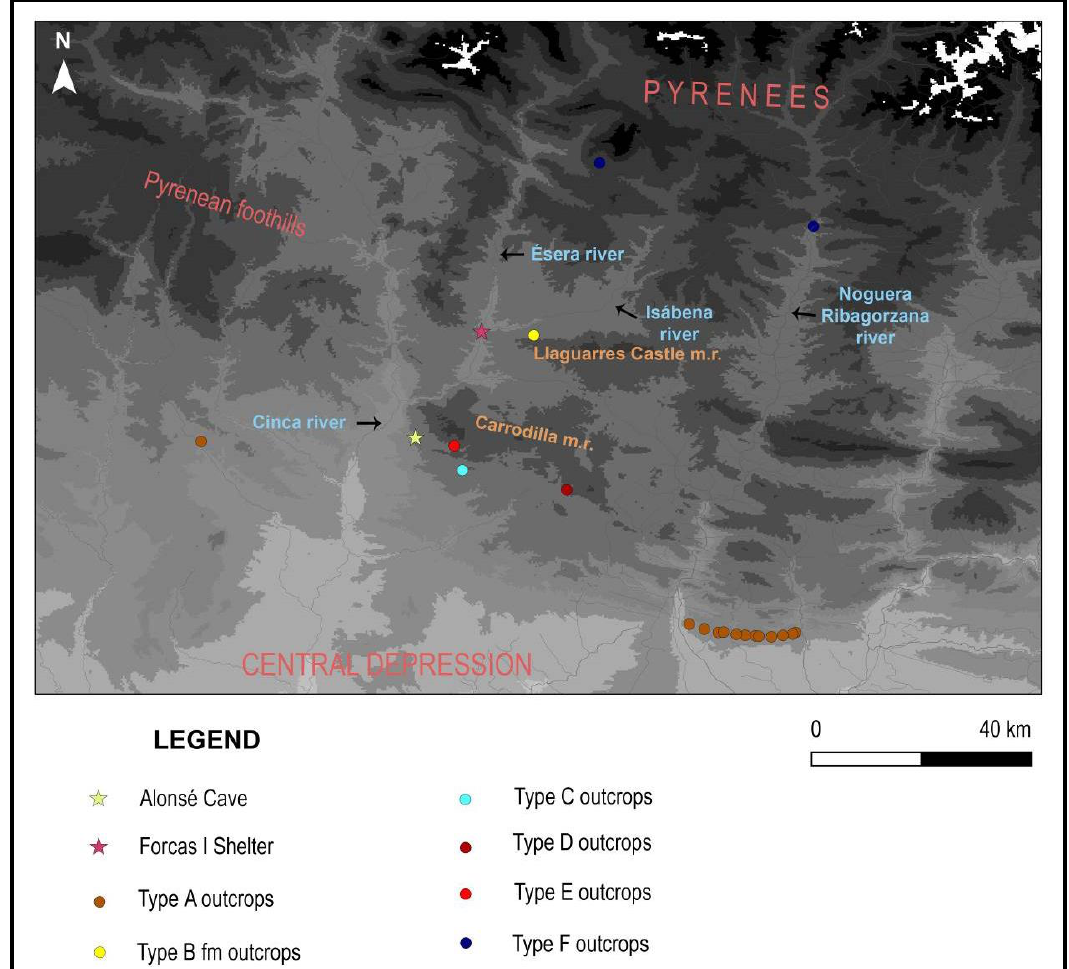
Figure 2. Location of the different geological formations with chert outcrops detected in the region.